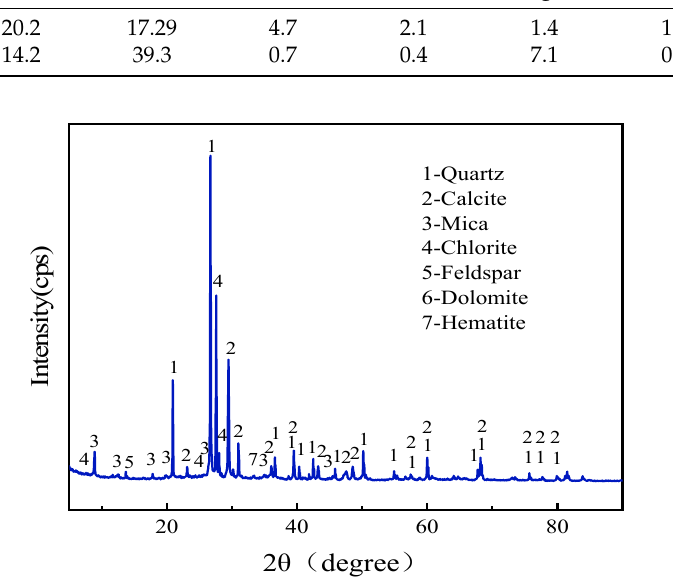
Figure 2. The XRD patterns of RP.